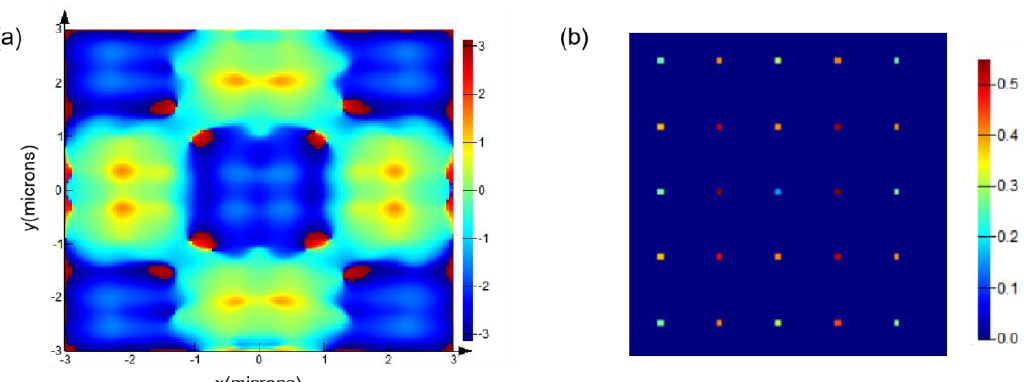
Figure 7. ( a ) Phase distributions of Ex of the transmitted field and ( b ) normalized diffractive intensity distribution in the far − field of the helical waveguide DG with two radii of R 1 = 40 nm and R 2 = 88 nm with x − pol light incident. The color bars show the phase and intensity distribution change in ( a ) and ( b ), respectively.